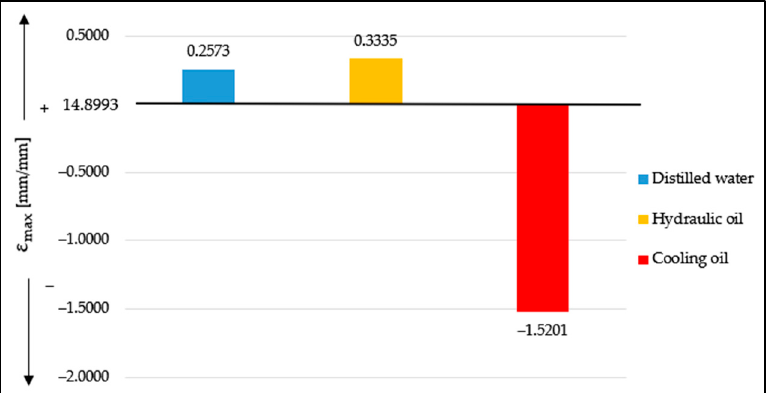
Figure 6. Comparison of the average maximum values of tensile stress for Ecoflex 00-10 specimens for each liquid medium.